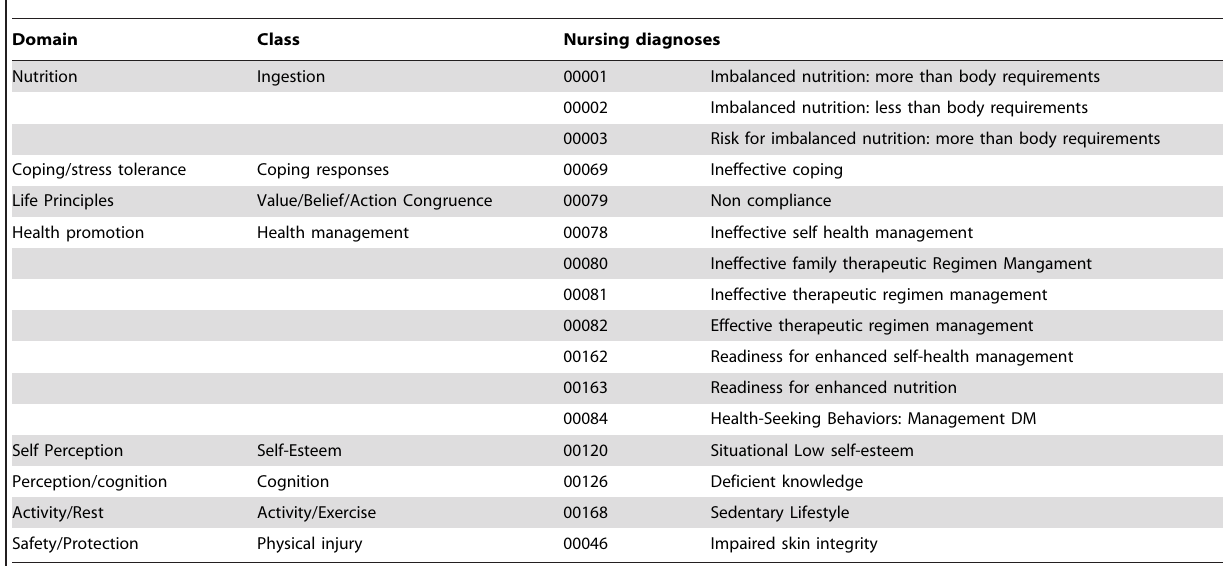
Table 1. Nursing diagnoses: domains, class, and titles.